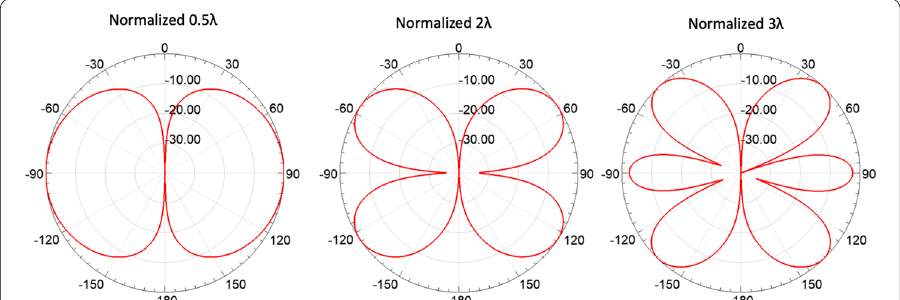
Fig. 9 Radiation pattern. Simulated radiation pattern for a dipole antenna at different